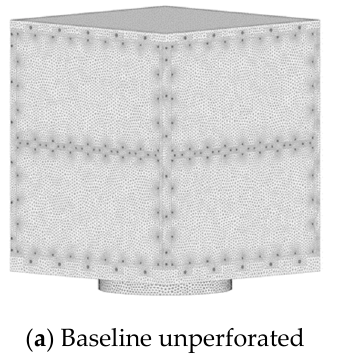
Figure 6. Mesh convergence study (typical case); converged mesh density shown in black.